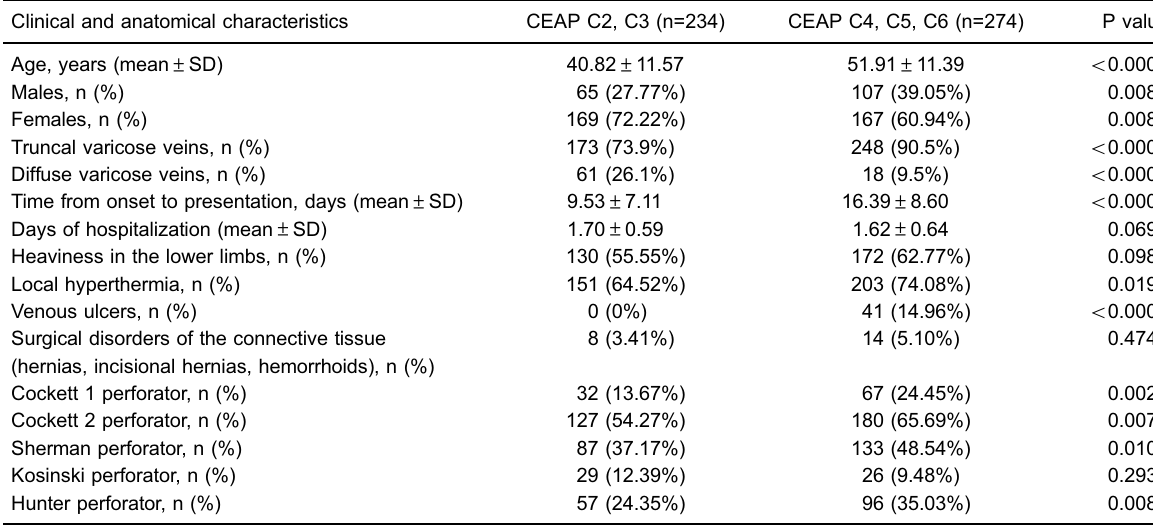
Table 2. Comparative analysis according to the CEAP (clinical, etiologic, anatomic, pathophysiologic) classi fi cation of the study population. Clinical and anatomical